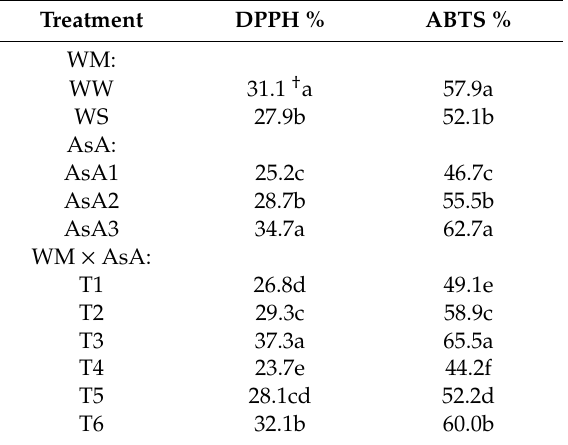
Table 5. The e ff ect of water management (WM) and ascorbic acid (AsA) on 2,2-diphenyl-1 -picrylhydrazyl-free radical scavenging assay (DPPH%) at 75 µ g mL − 1 and 2,2 (cid:48) -azino- bis(3-ethylbenzothiazoline-6-sulfonic acid) enzymatic assay (ABTS%) of common bean plants. Treatment DPPH %